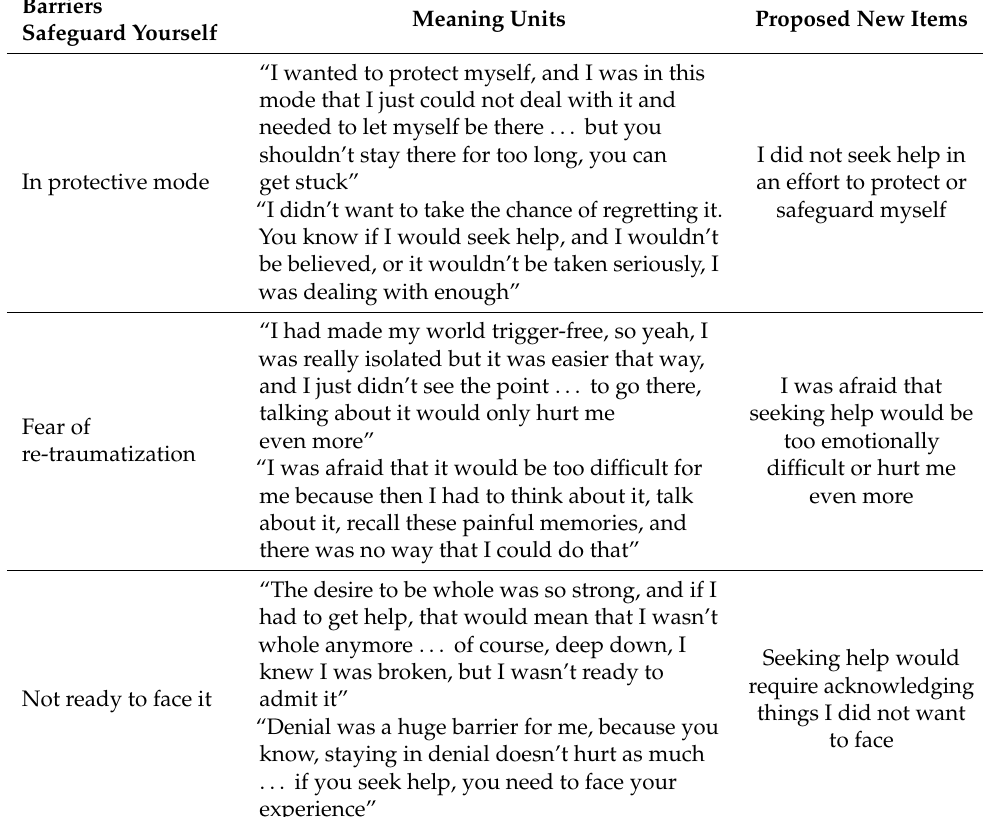
Table 4. Safeguard Yourself